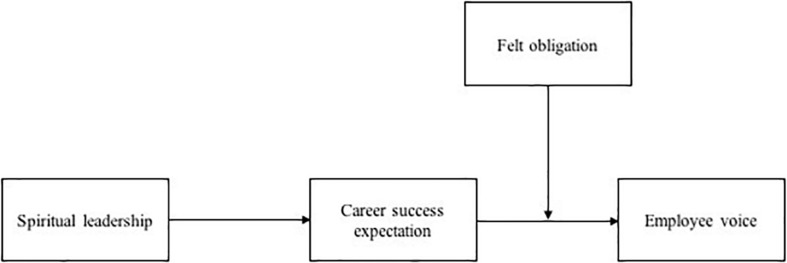
Hypothesized model.